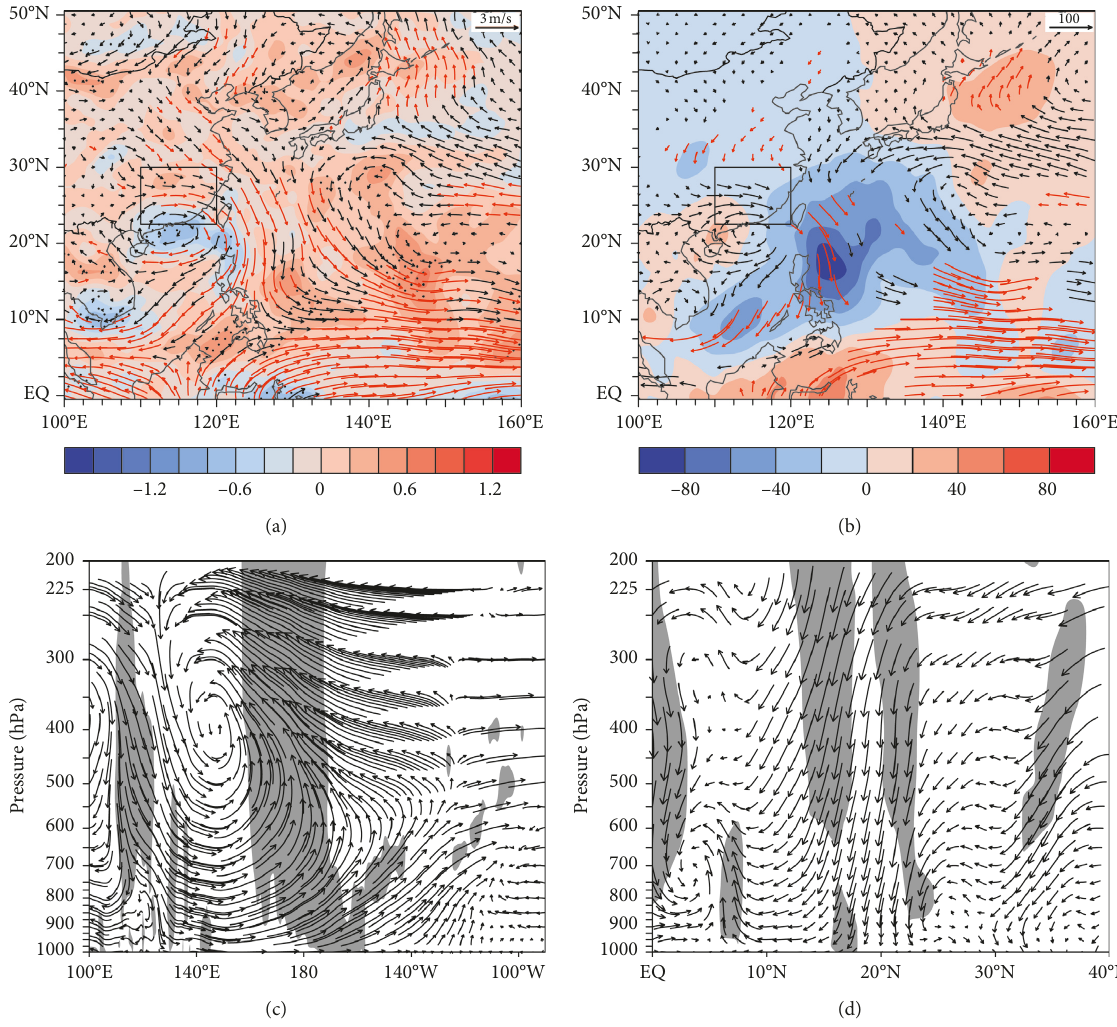
Figure 8: The difference between the positive year and negative year of dipole mode: (a), (b), (c), and (d) same as (a), (b), (c), and (d) in Figure 5. (a) 850hPa u ; v & vorticity diff. (b) Moisture cliff & divergence diff. (c) u ; w ∗ − 100 diff. (d) v ; w ∗ − 100